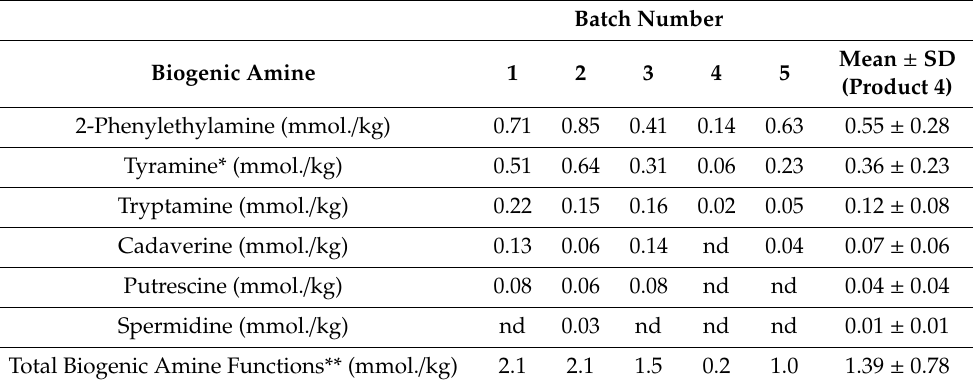
Table 2. Biogenic amine concentrations, together with that of total biogenic amine function (mmol. / kg), for 5 separate batches of Product 4 (1–5). All these amines were undetectable in all separate batches of Products